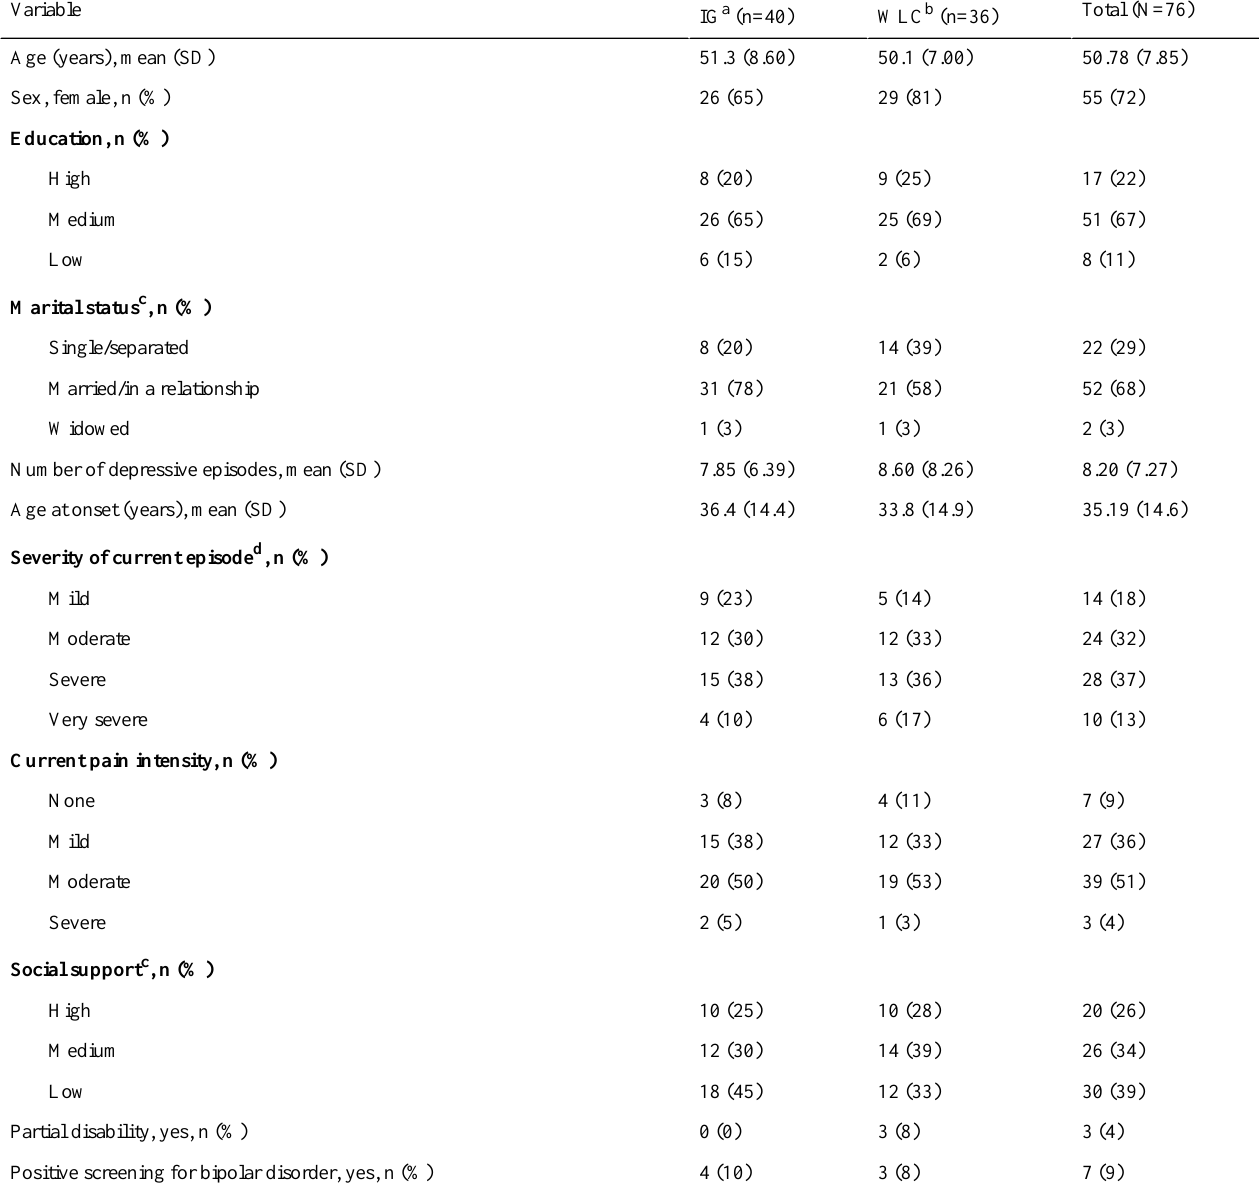
Table 3. Demographics and clinical